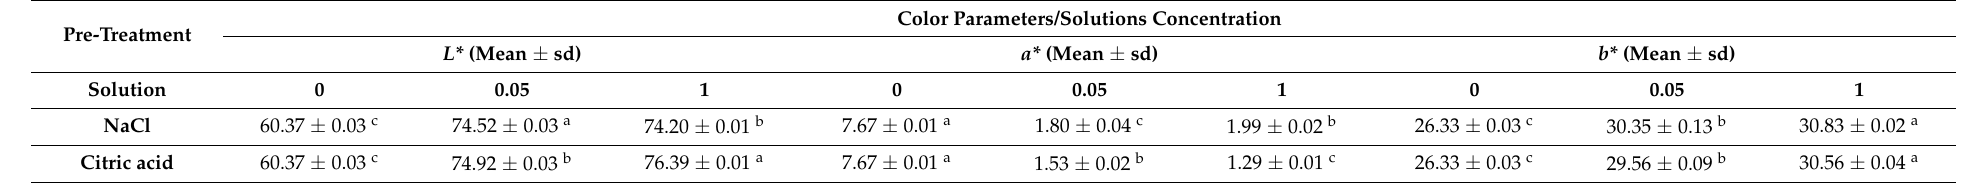
Table 4. Color parameters ( L* , a* , b* ) of French fries pre-treated with NaCl and citric acid